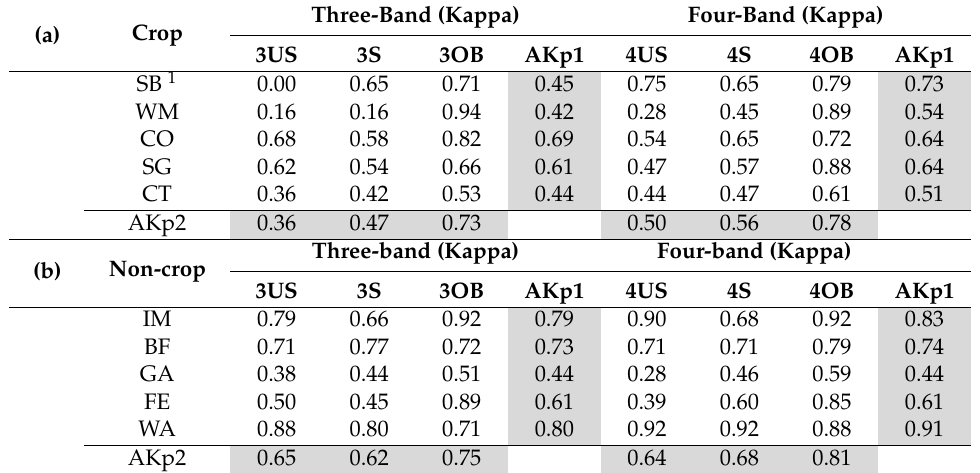
Table 5. Results of kappa analysis by three methods and two images for ( a ) Crop and ( b )